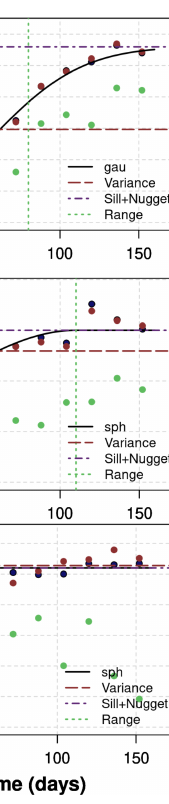
Figure 4. Comparison of semivariograms between automated mea- surements ( F A ) of soil greenhouse gas fluxes (solid black line) and for optimized samples using a temporal univariate Latin hypercube sampling (tuLHs) approach (red circles) or fixed temporal stratifi- cation (green circles) with k = 24. Semivariograms are presented for soil CO 2 (a) , CH 4 (b) , and N 2 O (c) fluxes. Semivariograms for measurements with k = 12 and k = 48 are shown in Figs. S7 and S8, respectively. Semivariogram fits were Gaussian (gau) or spherical (sph).